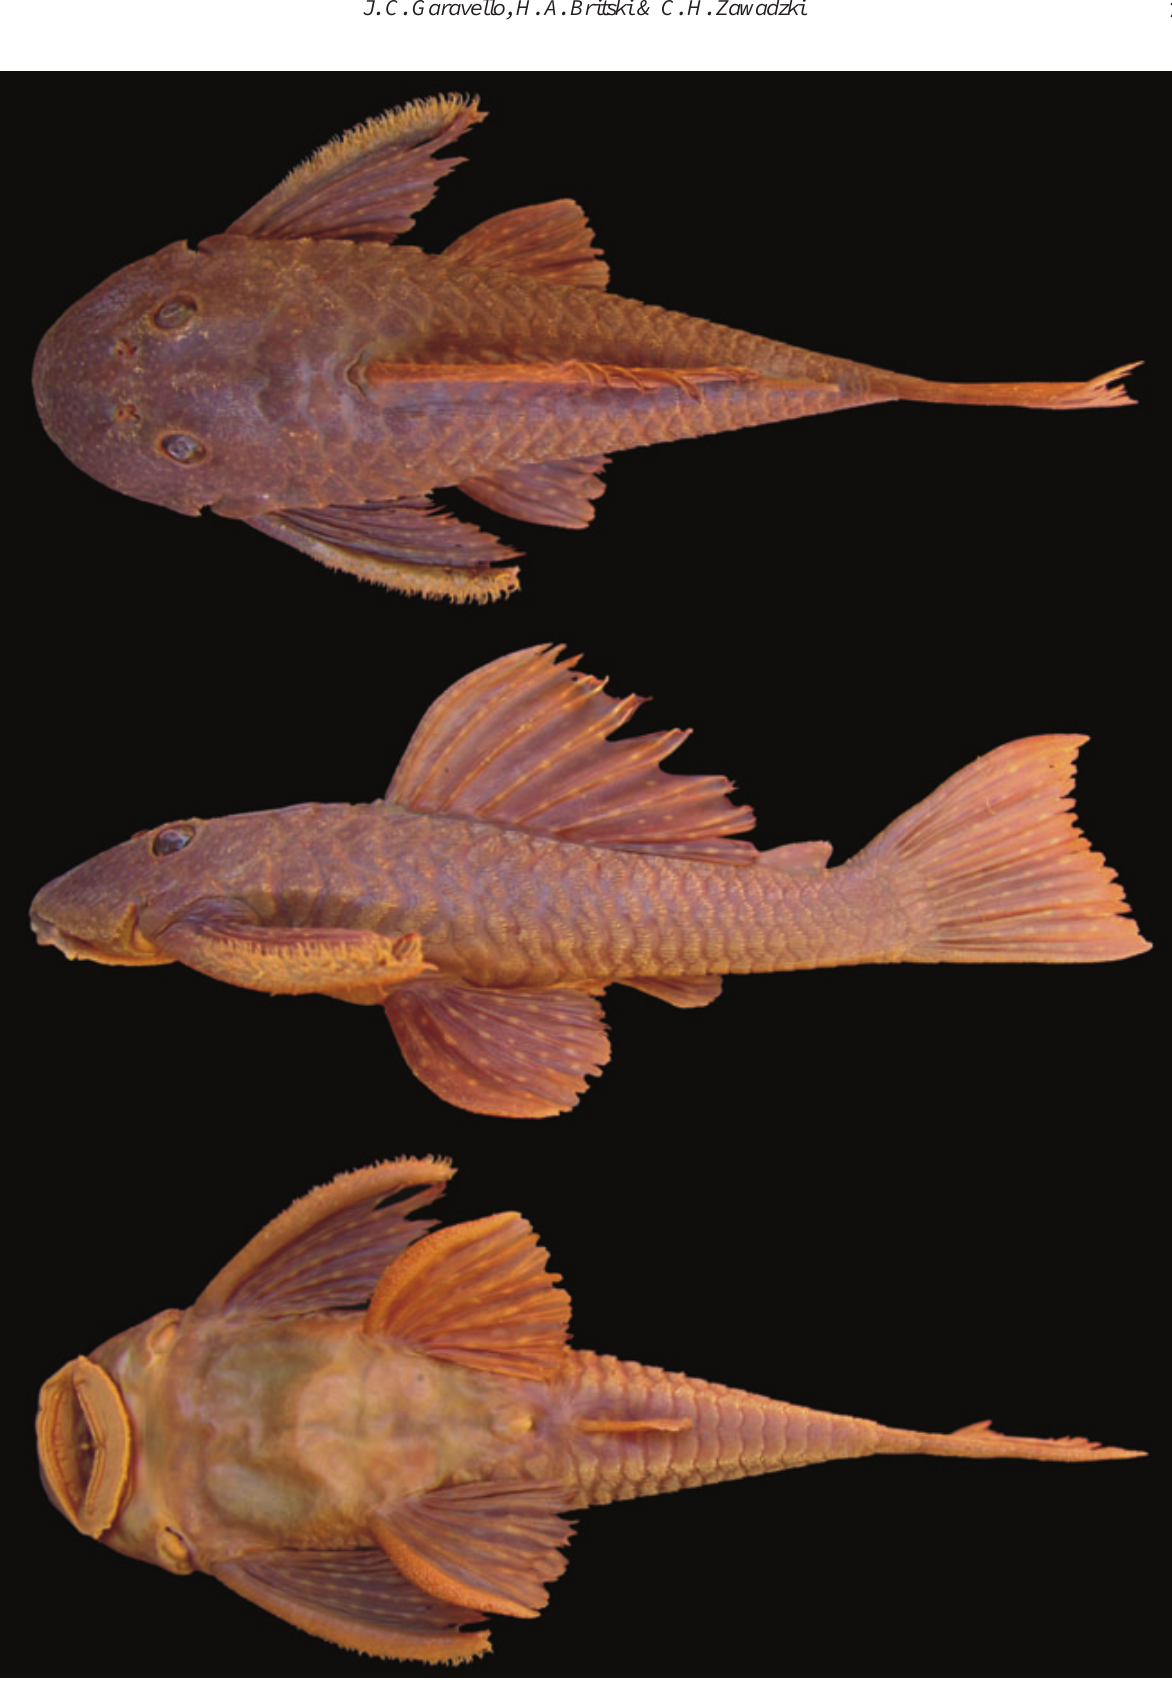
Fig. 6. Hypostomus myersi , NUP 680, 146.2 mm SL, Salto Caxias reservoir, rio Iguaçu, Municipality of Capitão Leônidas Marques/Nova Prata do Iguaçu, Paraná,